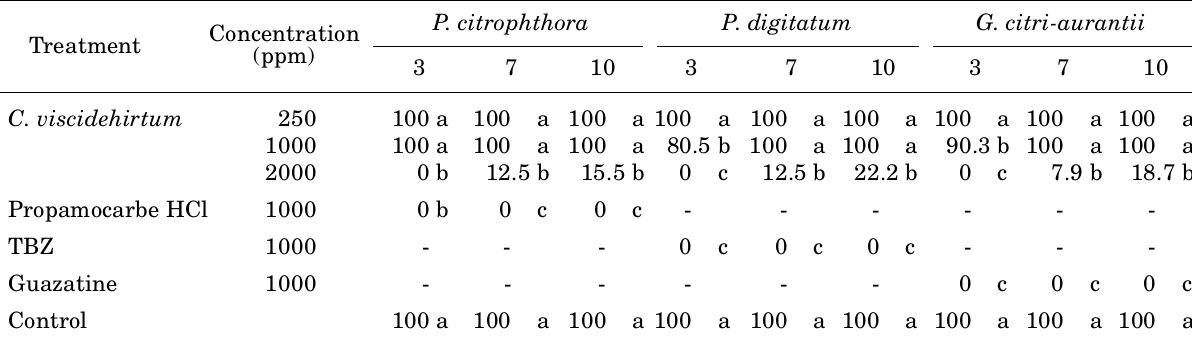
Table 3. Percentage of rotted fruits ( Citrus reticulata Blanco cv. Nules) after treatment with essential oil of Chrysan- themum viscidehirtum after 3, 7 and 10 storage days